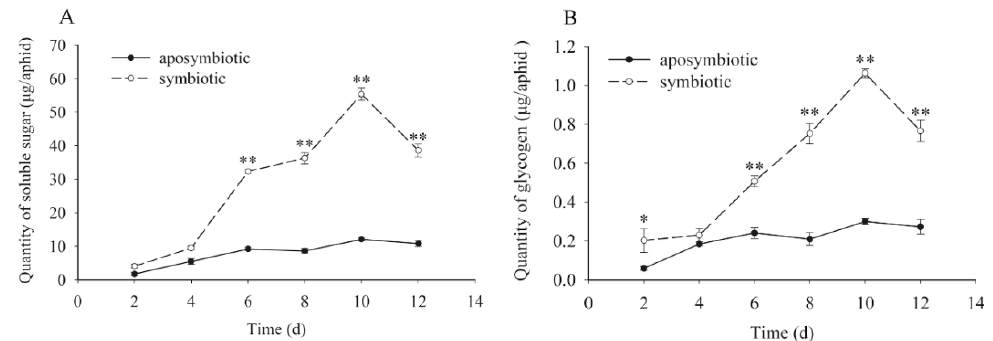
Figure 3. Dynamic changes of soluble sugars and glycogen in pea aphids that were Buchnera absent or infected. Black dot: rifampicin-treated aphid; Clear circle: healthy control aphid. The black dot or clear circle with error bars were mean ± standard error. The star “*” means significant differences between the antibiotic-treated and control aphids at 0.05, the double star “**” means significant differences between the antibiotic-treated and control aphids at 0.01. ( A ) Dynamic changes of soluble sugars ( t = 4.508, df = 16, p < 0.01 on day 6; t = 14.486, df = 16, p < 0.01 on day 8; t = 13.740, df = 16, p < 0.01 on day 10; t = 14.923, df = 16, p < 0.01 on day 12). ( B ) Dynamic changes of glycogen ( t = 2.346, df = 16, p = 0.041 on day 2; t = 4.083, df = 16, p < 0.01 on day 6; t = 8.673, df = 16, p < 0.01 on day 8; t = 26.878, df = 16, p < 0.01 on day 10; t = 7.381, df = 16, p < 0.01 on day